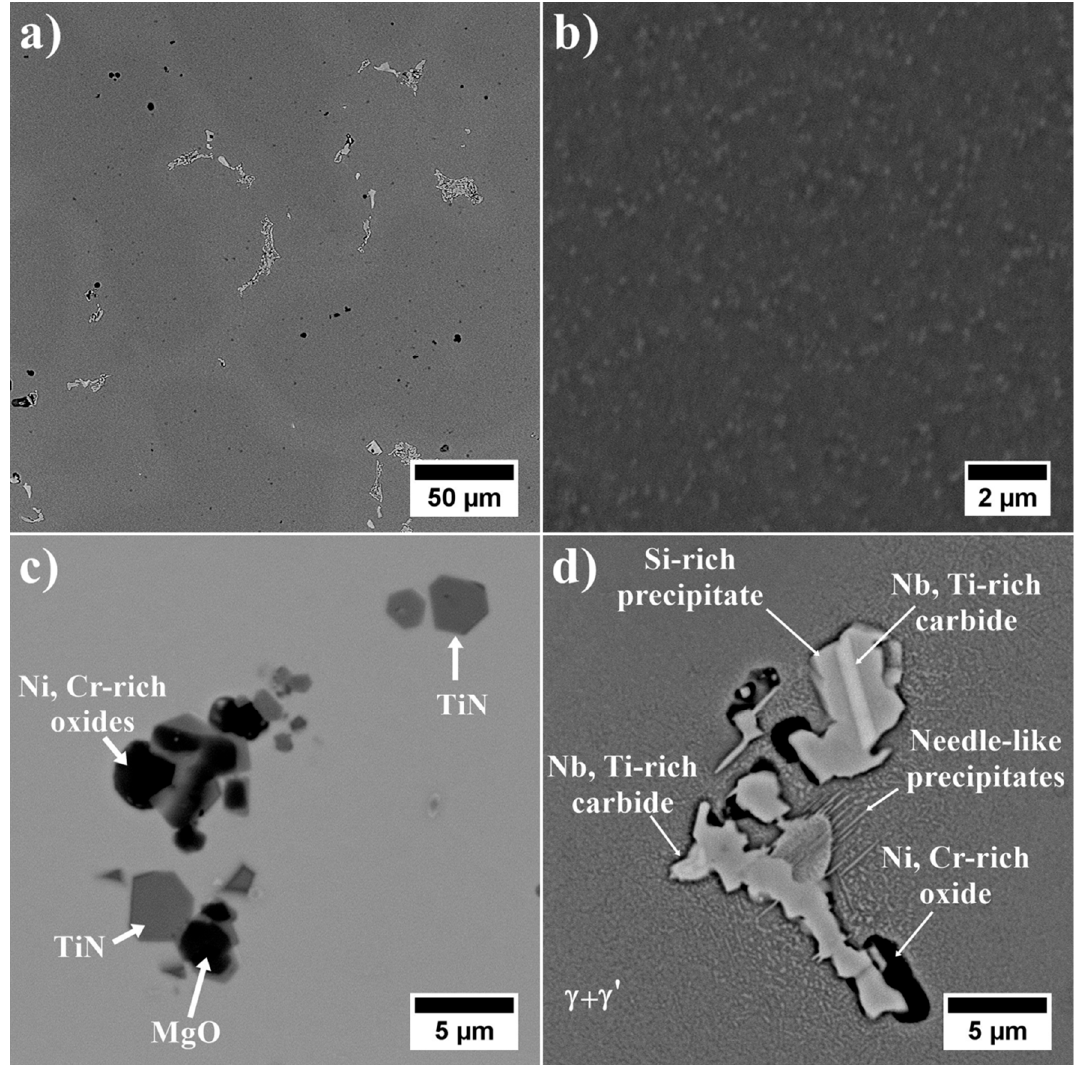
Figure 7. As-cast microstructure of remelted Inconel 740: ( a ) local segregation of microstructural constituents; ( b ) γ ’ precipitates in the dendritic region; ( c ) nitrides and oxides in the dendritic region; ( d ) morphology of precipitates in interdendritic spaces.